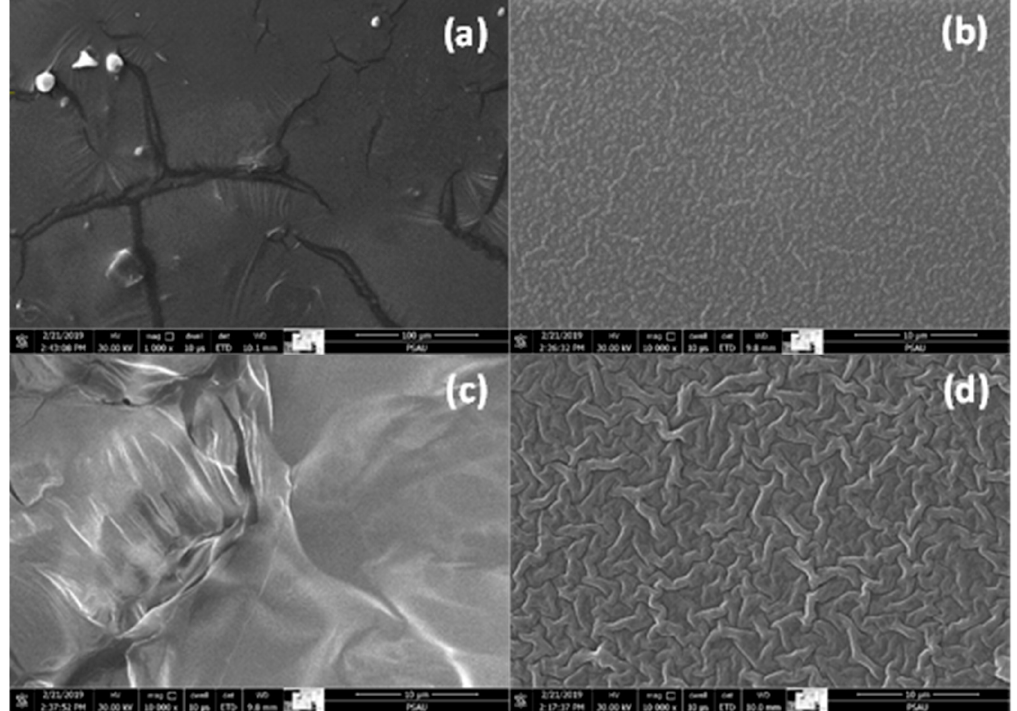
Figure 4. SEM images of ( a , b ) 0.5 M RT film, dried and thermally dried, respectively, and ( c , d ) 1.0 M RT film, dried and thermally dried, respectively.